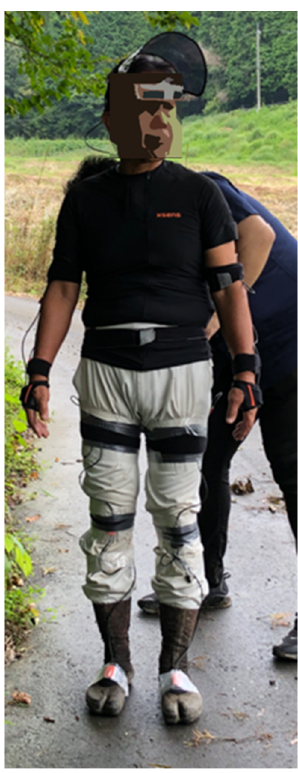
Figure 2. Subject equipped with the motion capture device Xsens MVN.